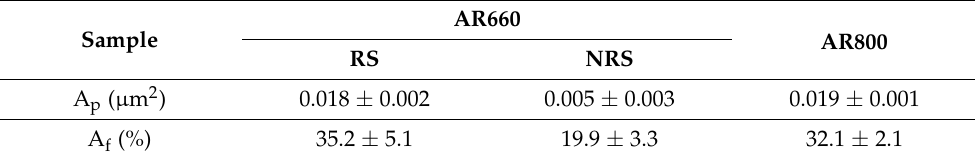
Table 3. The mean area per particle and area fraction of particles in various samples.